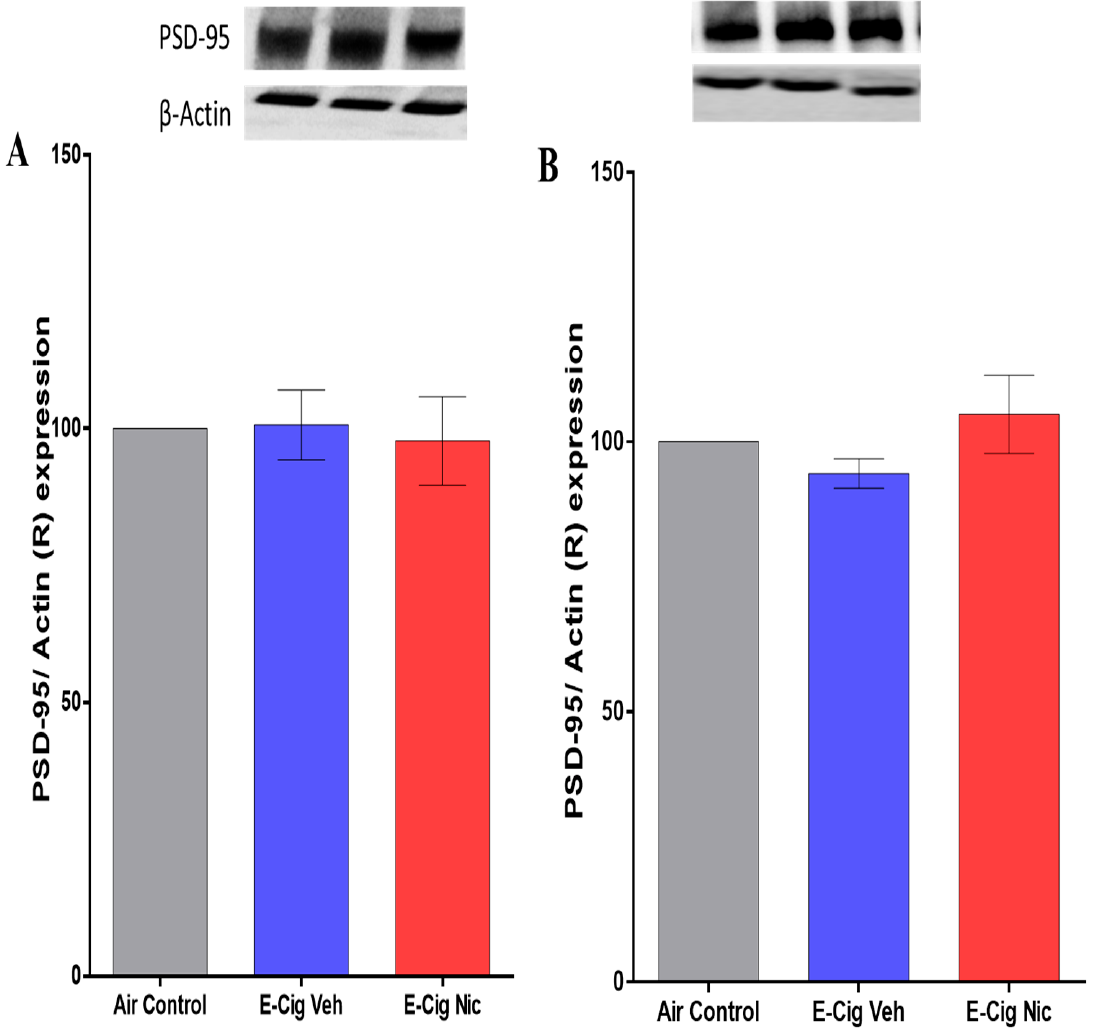
Figure 9. Relative (R) expression of PSD-95 in the hippocampus following four-week inhalation of e-cigarette vapors containing nicotine. ( A ) Representative PSD-95 expression blots in males of all three groups (upper panel) and corresponding quantitative statistical analysis (lower panel). ( B ) Representative PSD-95 expression blots in females of all three groups (upper panel) and corresponding statistical analysis (lower panel). One-way analysis of variance (ANOVA) did not show significant differences between the three groups in the hippocampal expression of the PSD-95. Data are presented as mean ± SEM (n = 3/group). E-cig, electronic cigarette; E-cig Veh, electronic cigarette with vehicle only; E-cig Nic, electronic cigarette with nicotine.